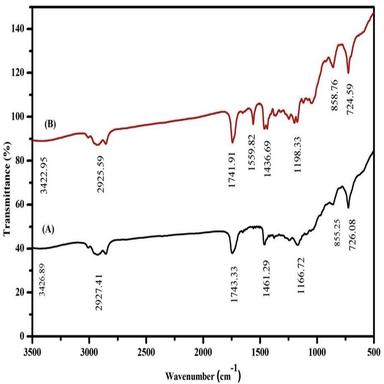
Comparison of FTIR spectra: (A) crude Castor oil; (B) fatty acid propyl ester (biodiesel) at constant reaction parameters: 50 ± 1 C 24 h, 6:1 alcohol to crude Castor oil ratio and10% hybrid BSC on oil amount.